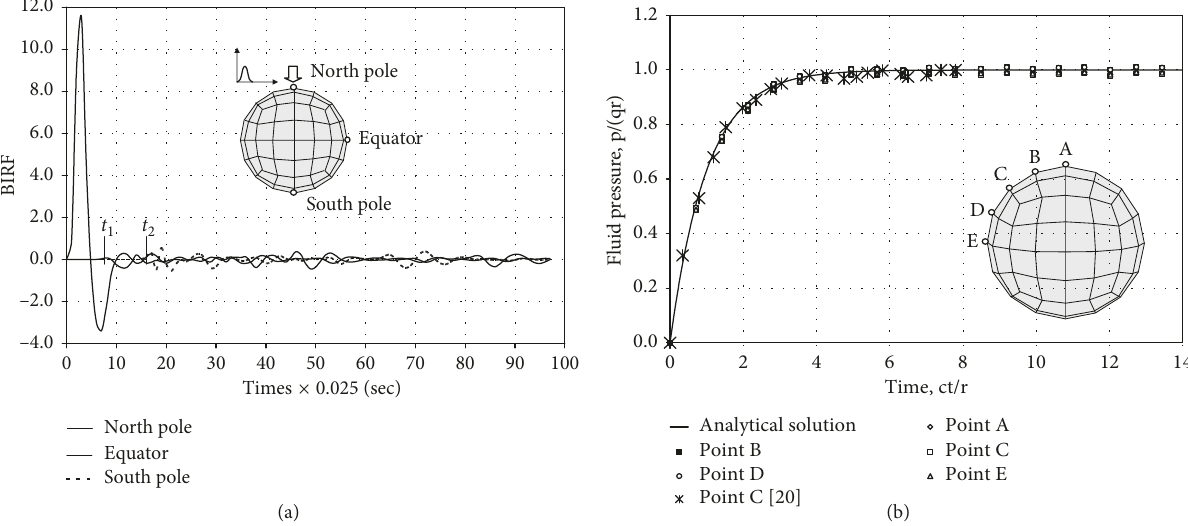
F IGURE 4: Wet surface solutions: (a) the BIRF of points on the “North Pole,” “Equator,” and “South Pole” due to B-spline flux at North Pole; (b) time history of the pressure field due to constant internal flux at specific points on the wet surface and comparison with analytical and other solutions in a nondimensional form where c is the pressure wave velocity, r is the radius of the sphere, t is time, p is the pressure field and q is the influx